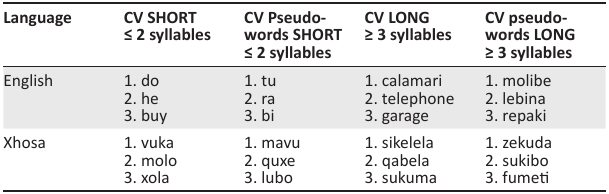
TABLE 2: Examples of stimuli. Language